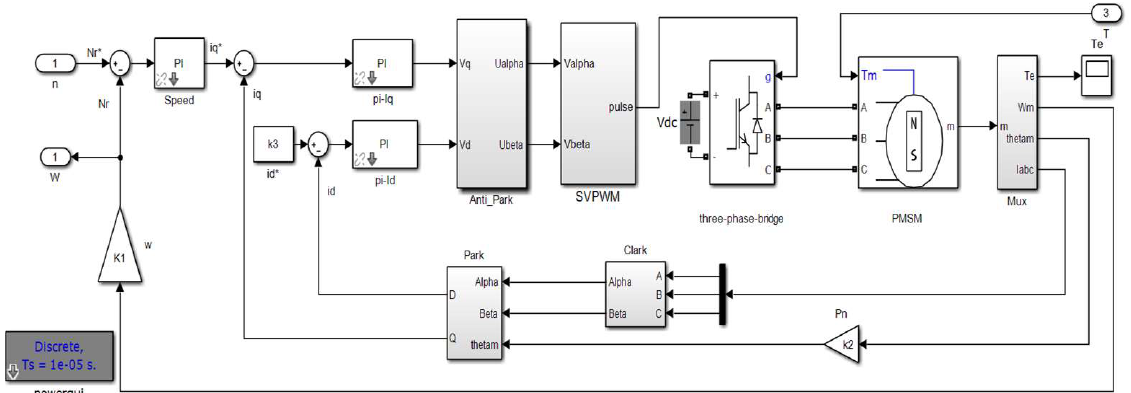
Figure 7. Servo motor vector control simulation model. Table 1. Current loop simulation model parameters. Parameter